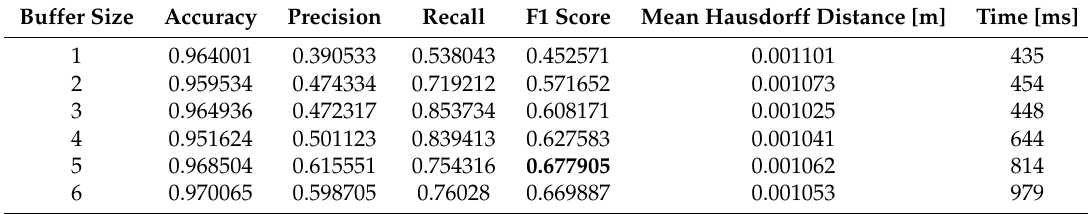
Figure 11. Color map visualization of F1 score dependence on Statistical Outlier Removal (SOR) filter parameters for each size of buffer 1–6. Table 1. SOR filter best results for multiple buffer sizes.